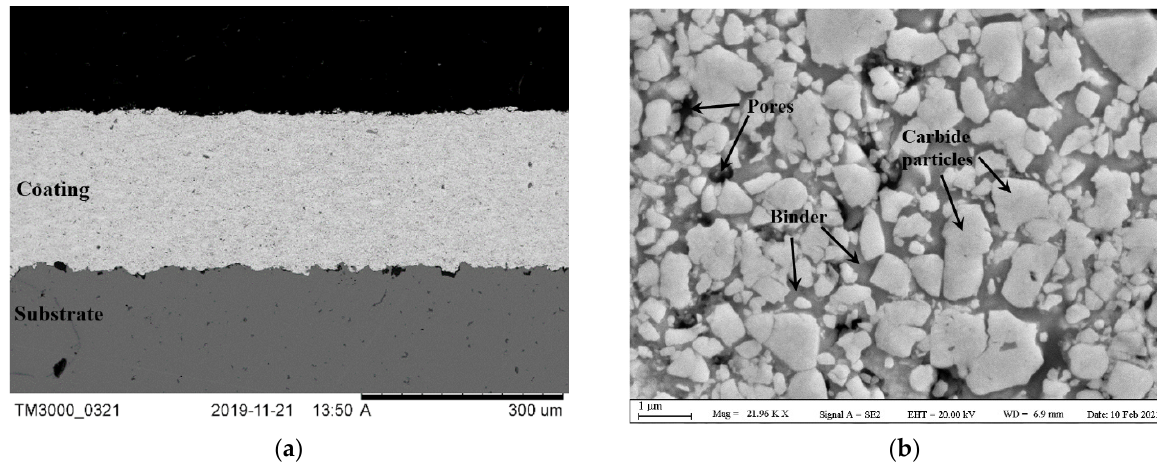
Figure 2. SEM images of cross-sections of deposited coatings at ( a ) low magnification and ( b ) high magnification.